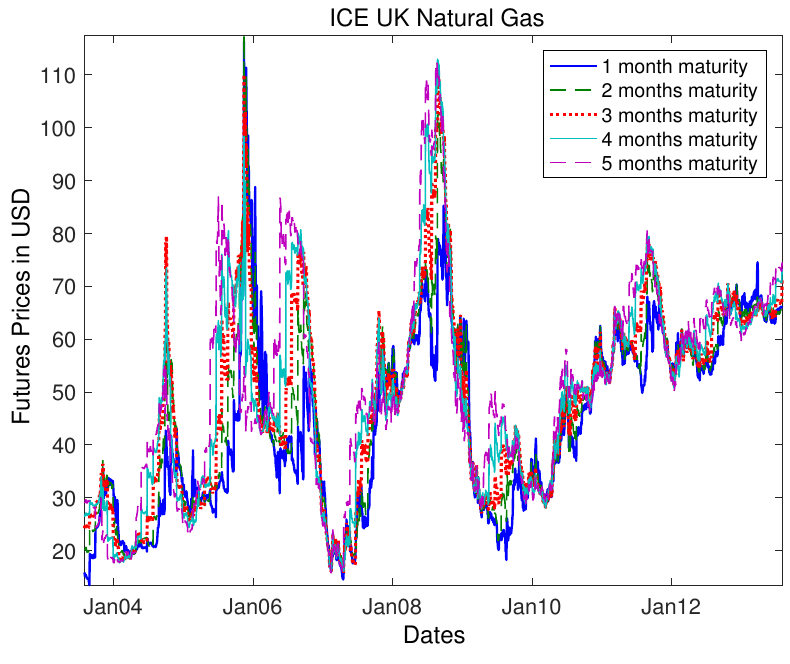
Figure 1. Prices of the ICE U.K. Natural Gas Futures with different